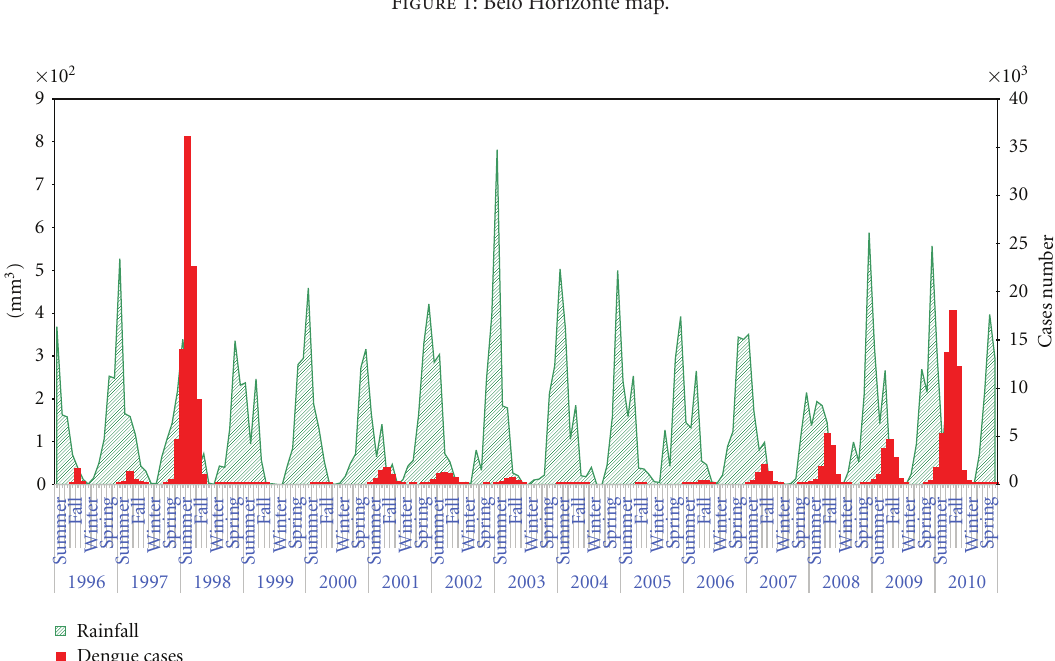
Figure 1: Belo Horizonte map.